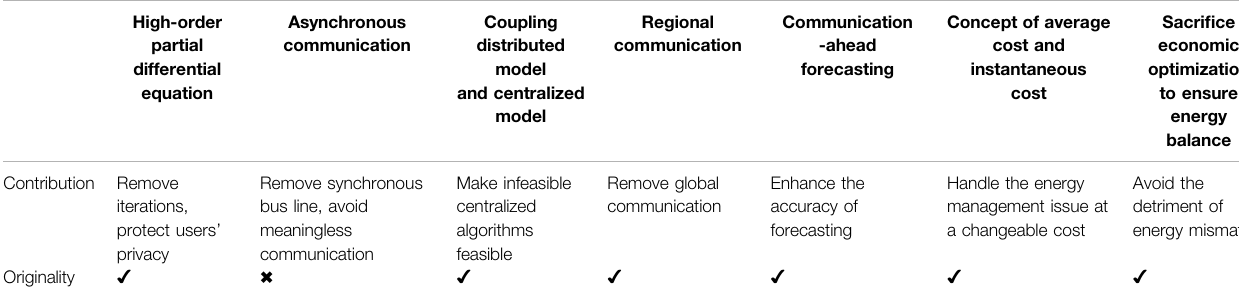
TABLE 2 | All technologies in RDETA and their contributions and original